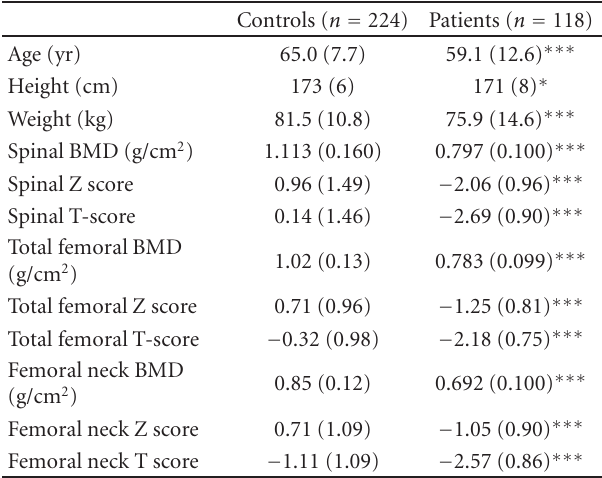
Table 1: Age, weight, height and bone mineral density of control male subjects and men with osteoporosis.